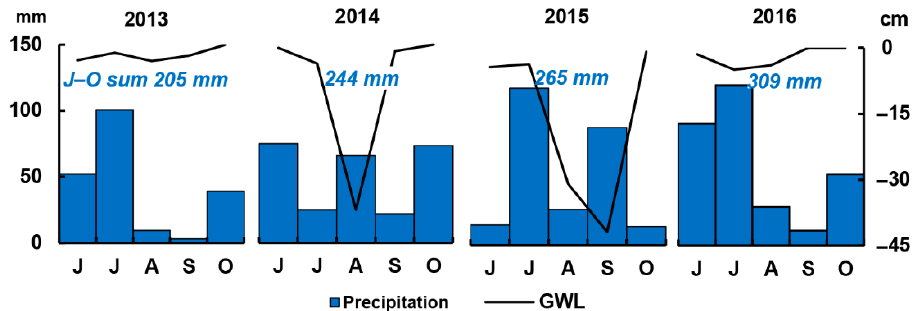
Figure 3. Monthly precipitation (measured directly at the study site) and GWL (negative values correspond to the groundwater level below the soil surface) from June to October of 2013–2016. Sums of the precipitation (mm) for the J–O period are shown above the columns in the chart.